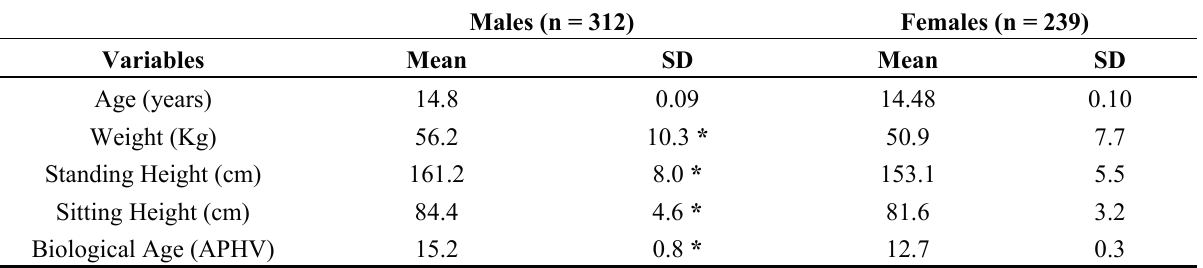
Table 1. Variables of physical growth, body weight and nutritional status of the study sample.